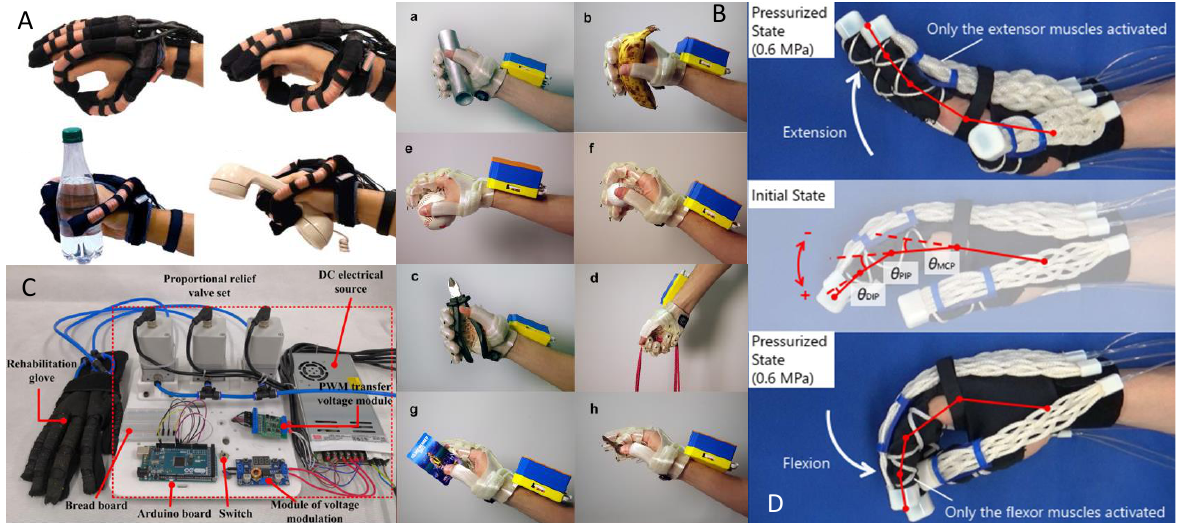
Figure 21. Gloves proposed both for Rehabilitation and for Assistance. ( A ) Hydraulically actuated soft glove, with moulded multi-segment elastomeric soft actuators with fiber reinforcements [48]. ( B ) Flexo-Glove, a tendon-driven rehabilitative and assistive glove, based on a 3D-printing pro- cess [41]. Letters (a–h) refer to the original source. Reprinted/adapted with permission from Ref. [41]. 2018, IEEE. ( C ) Soft, a glove with soft joint structure based on composite fabric material [31]. ( D ) Soft glove with thin McKibben pneumatic actuators [60]. Reprinted/adapted with permission from Ref. [60]. 2020,